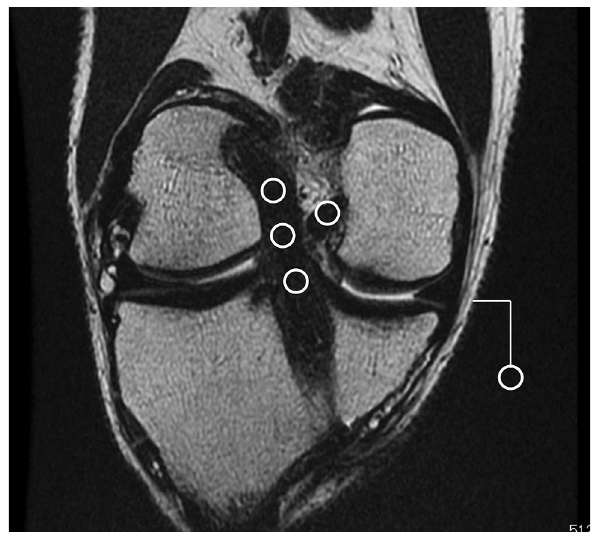
Figure 2. T2-weighted magnetic resonance image of the transplanted graft: oblique coronal slice. Graft signals at the 5 points (white circles) are calculated with circular regions of interest: three intra-articular sites of transplanted graft (proximal, mid-substance, and distal), posterior cruciate ligament, and